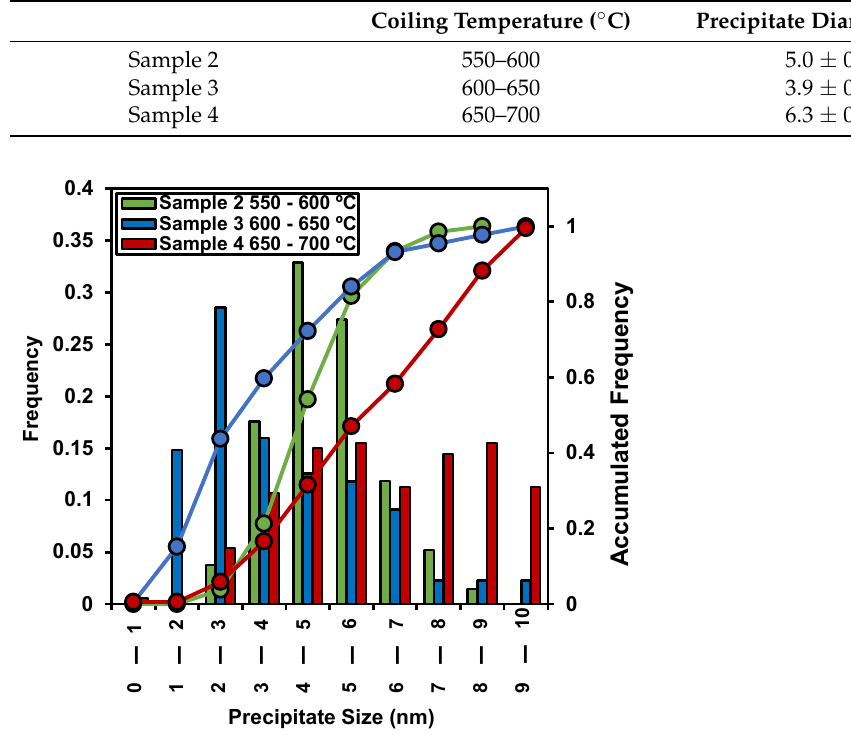
Figure 13. Effect of coiling temperature on precipitate size distribution (below 10 nm).